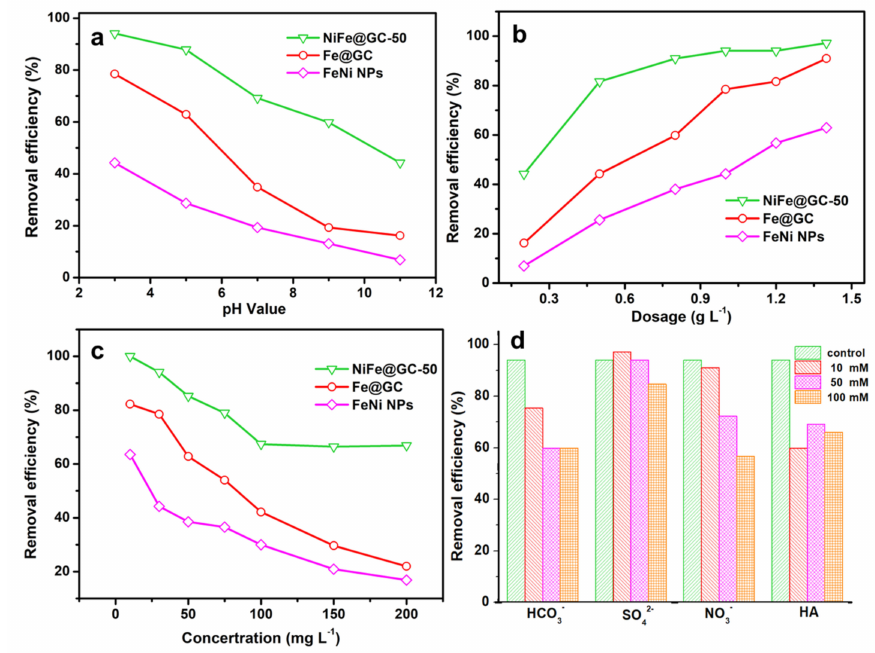
Figure 5. The effect of ( a ) pH value, ( b ) dosage, ( c ) initial TCP concentration, ( d ) co-existing ions and HA on the removal efficiency. (Except for the target parameter, other experimental conditions were as follows: pH = 3.0, dosage = 1.0 g L − 1 , TCP = 30 mg L − 1 , T = 298.15